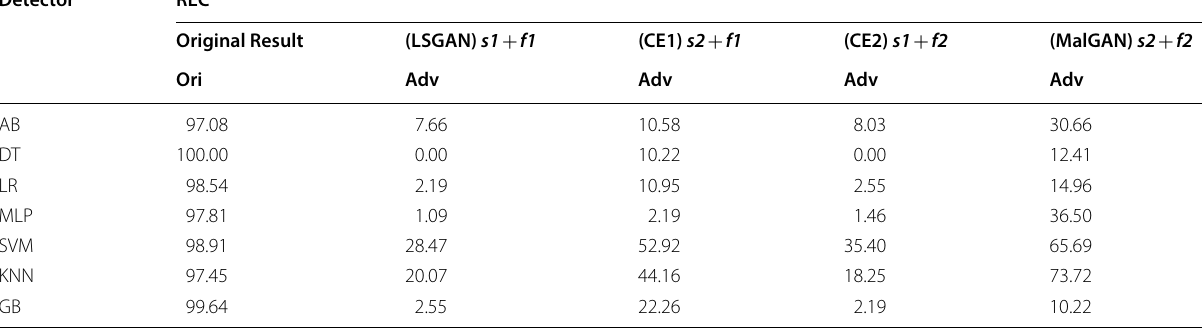
Table 13 The recognition rate comparison of different combinations (%)